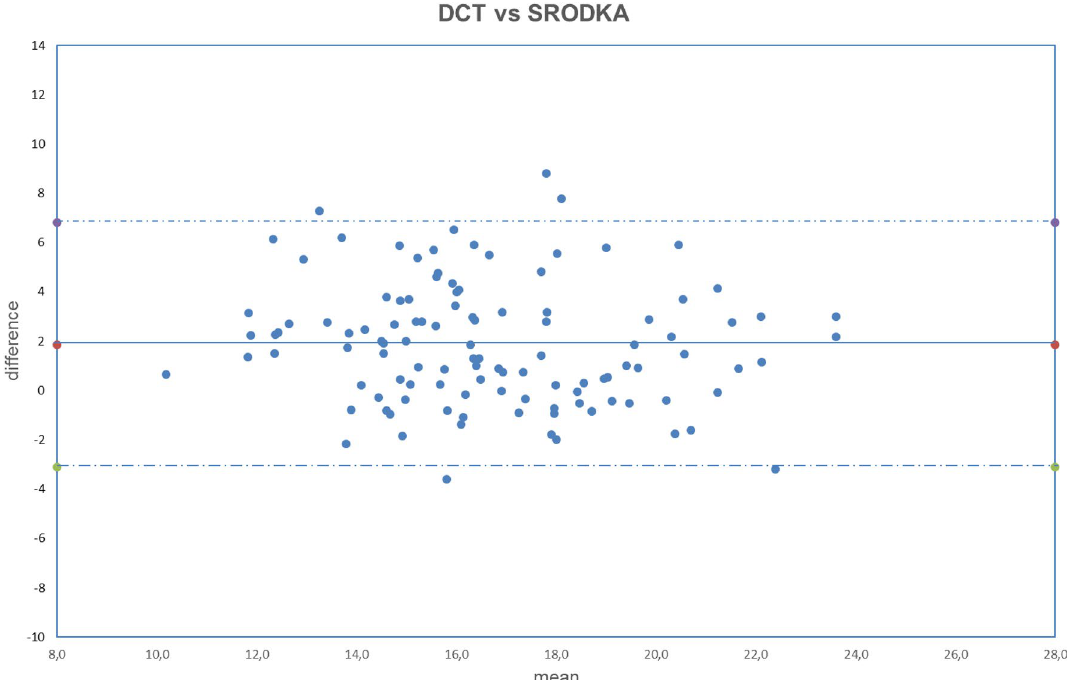
Figure 5. Bland–Altman plot between IOP measured with DCT and GAT corrected with Śródka formula. Dashed line: mean difference. Dash-dotted lines: mean difference (1.86 mmHg) ± 2 standard deviation (2.48 mmHg) of the differences.